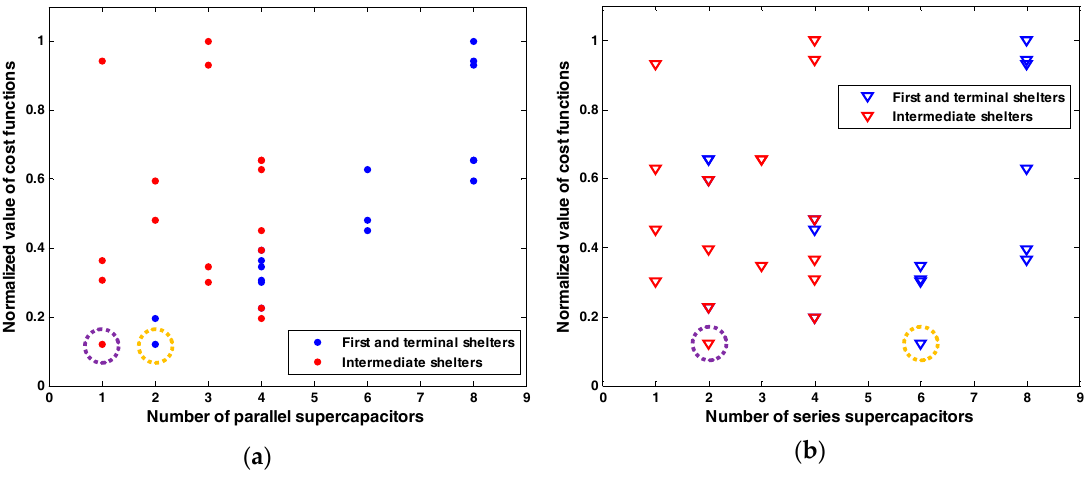
Figure 7. Supercapacitors that must be installed at the initial and terminal stops: ( a ) Number of parallel supercapacitors (SC) for the first and terminal shelters (blue) and the intermediate shelters (red); and ( b ) Number of series SC for the first and terminal shelters (blue) and the intermediate shelters (red).